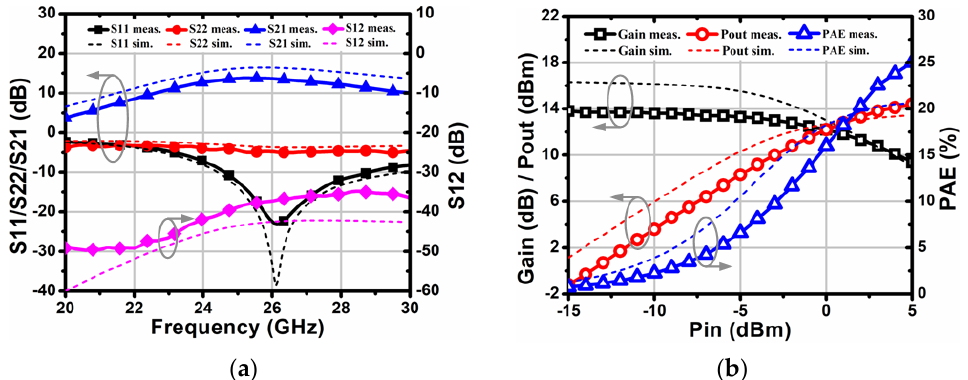
Figure 7. ( a ) Small-signal measurements and simulations of the PA, ( b ) large-signal measurements and simulations of the PA.